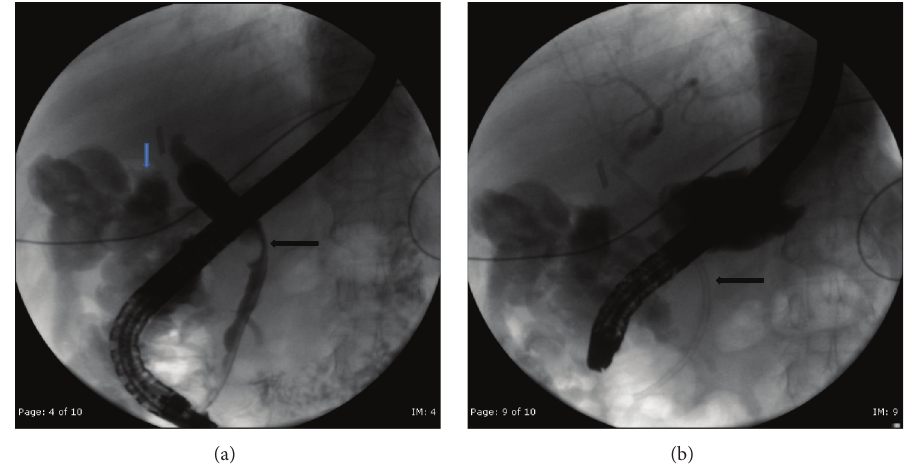
Figure 3: (a) ERCP showing compression of common hepatic duct from remnant cystic duct stone (black arrow) and bile leak in background (blue arrow). (b) Fluoroscopic image after stent placement (black arrow).